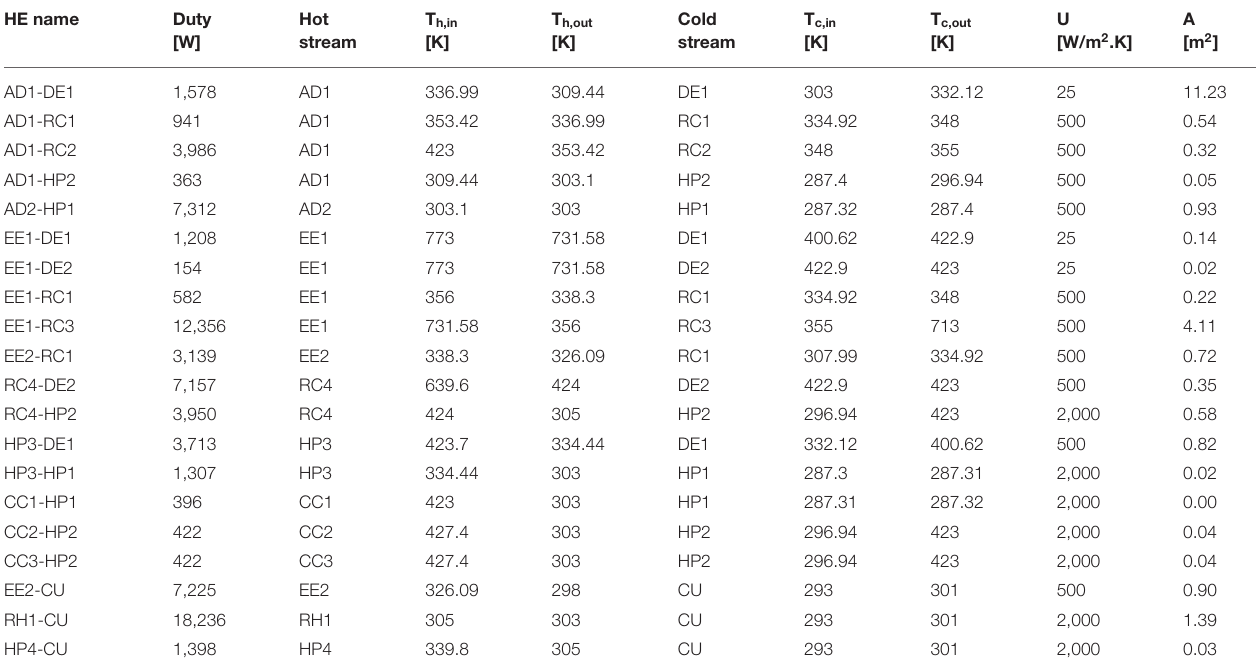
TABLE 3 | Heat exchanger network synthesis for CO 2 capture